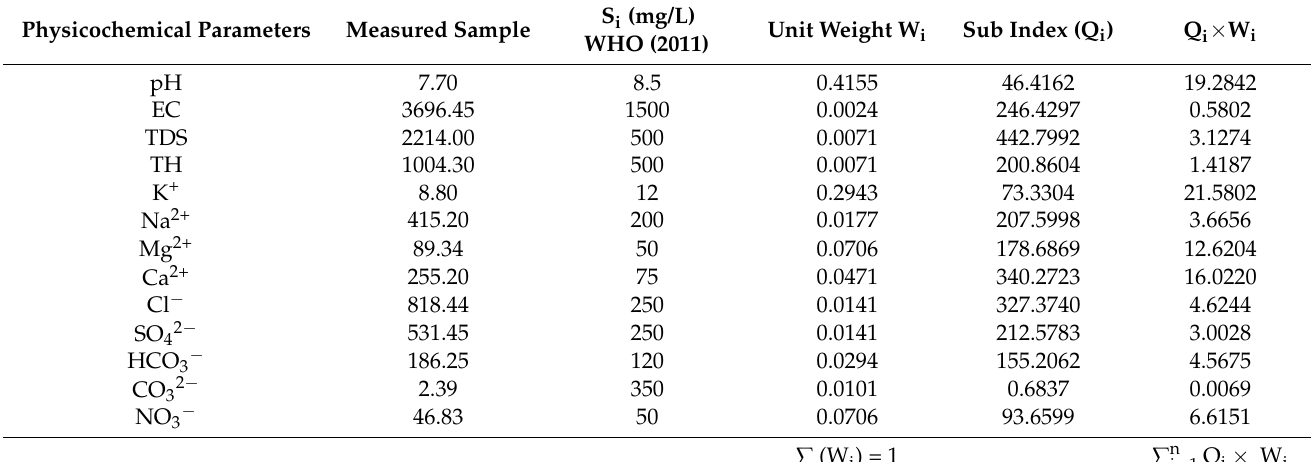
Table 2. Arithmetic rating method for calculation of drinking water quality index